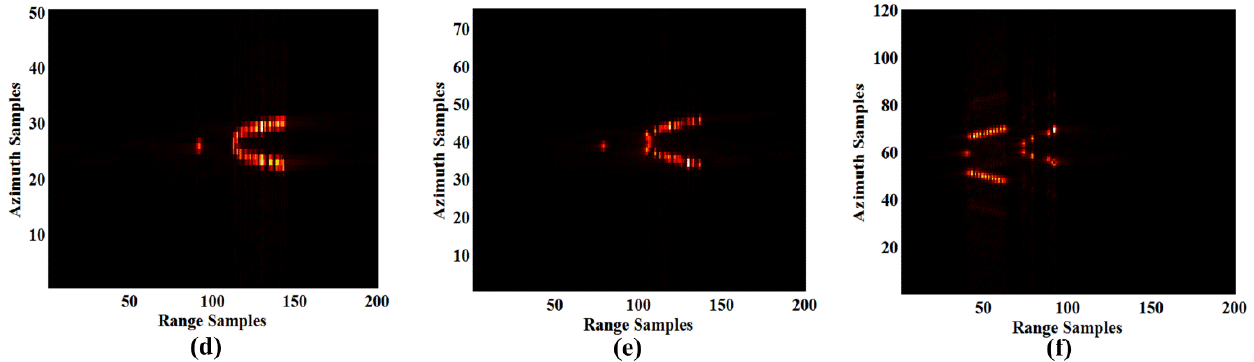
Figure 23. ISAR image of the hypersonic target in scenes 6 and 7 using X-band, Ku-band, and Ka-band radar. ( a ) X-band in scene 6. ( b ) Ku-band in scene 6. ( c ) Ka-band in scene 6. ( d ) X-band in scene 7. ( e ) Ku-band in scene 7. ( f ) Ka-band in scene 7.